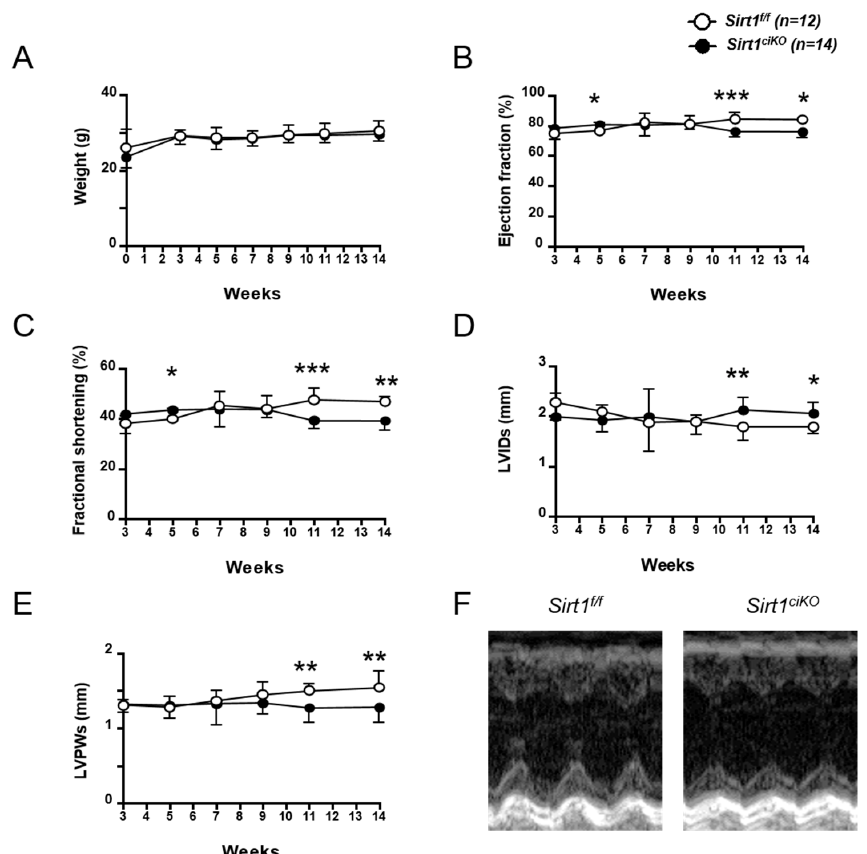
Figure 2. Progression of body weight and cardiac function of cardiac-specific knockout mice during 14 weeks after Sirt1 deletion induction. ( A ) Body weight. ( B ) Left ventricular ejection fraction. ( C ) Left ventricular fractional shortening. ( D ) Left ventricular internal dimension at end-systole (LVIDs). ( E ) Left ventricular posterior wall thickness at end-systole (LVPWs). ( F ) Representative M-mode images of the left ventricle (14 weeks after induction of Sirt1 deletion). ( n = 12 to 14 per experimental group), * p < 0.05; ** p < 0.01; *** p < 0.001 Sirt1 f/f versus Sirt1 ciKO .